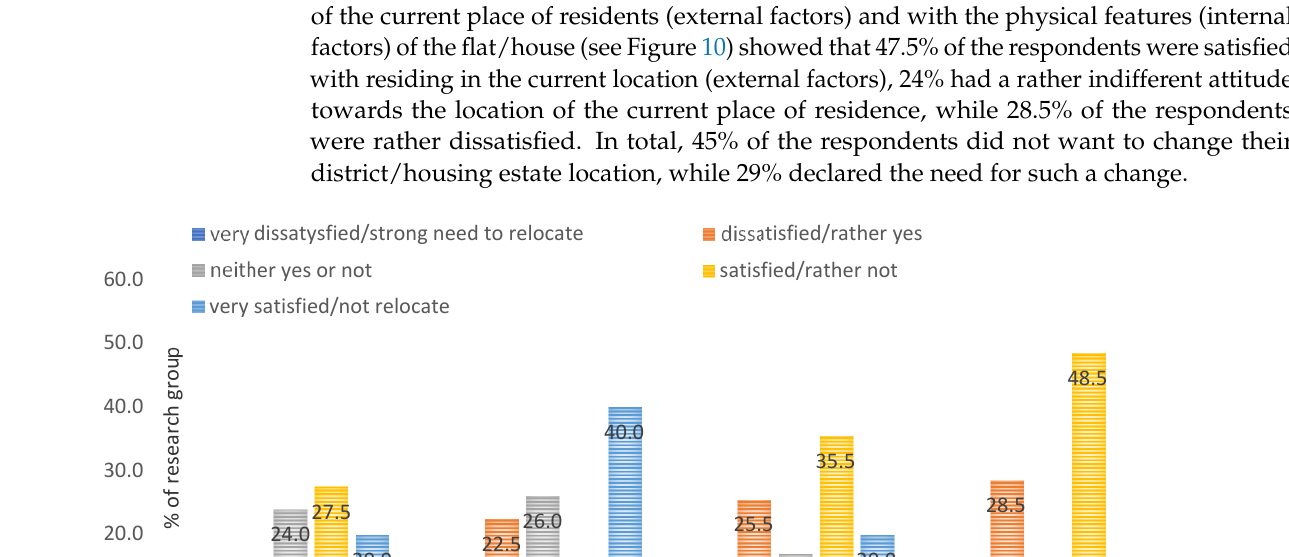
14 of 20 Figure 9. Differences in the perception of internal factors, broken down by age groups. Source: own study. Statistically significant differences in the change of the perception of internal factors (for the entire population), examined using the χ 2 test (Chi-squared test) at a significance level α < 0.10, were found for six attributes (described by the symbols I1, I2, I8, I9, I14, and I17, see Table 3). Analysis of the respondents’ opinions on the level of satisfaction with the location of